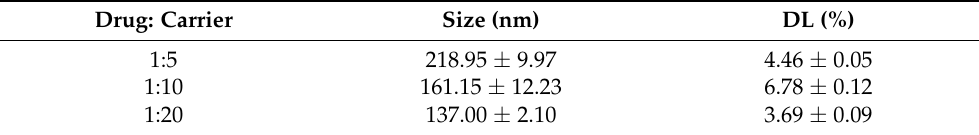
Table 1. Effect of the ratio of drug to carrier on